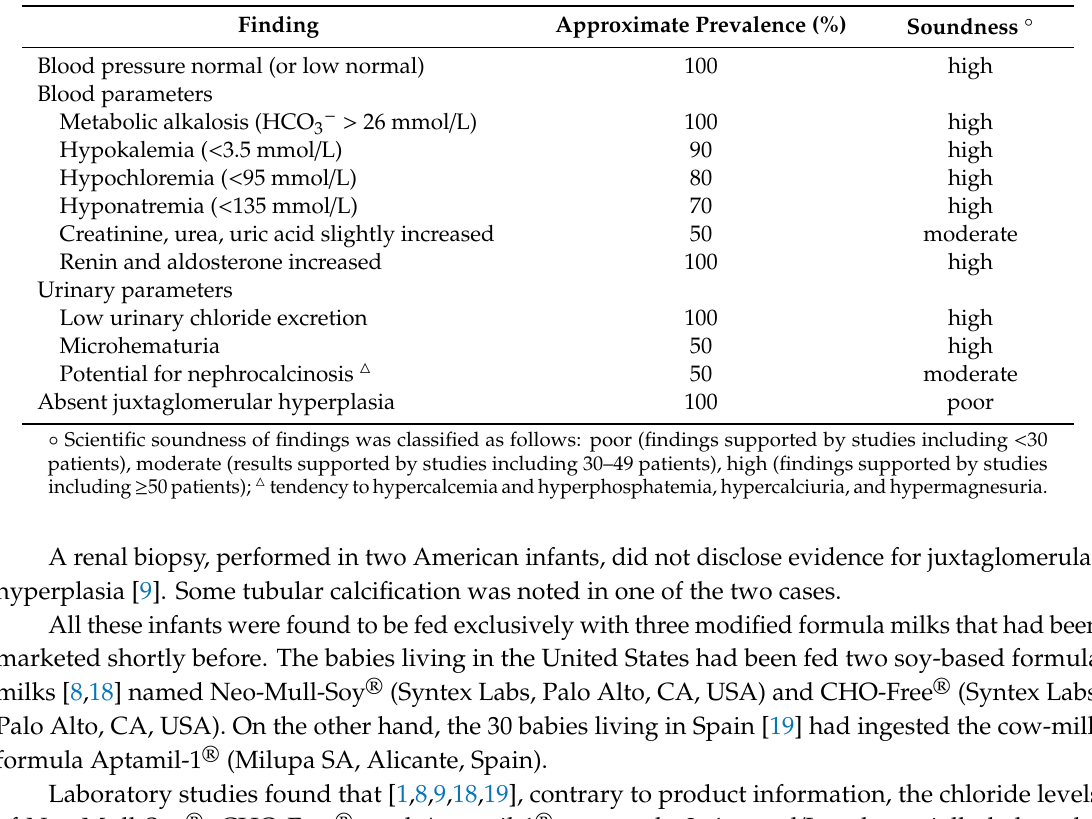
Table 2. Findings in infants of both sexes (no exact information on the sex ratio was available) with failure to thrive, constipation, food refusal, muscular weakness, and delayed psychomotor development fed a low-chloride formula